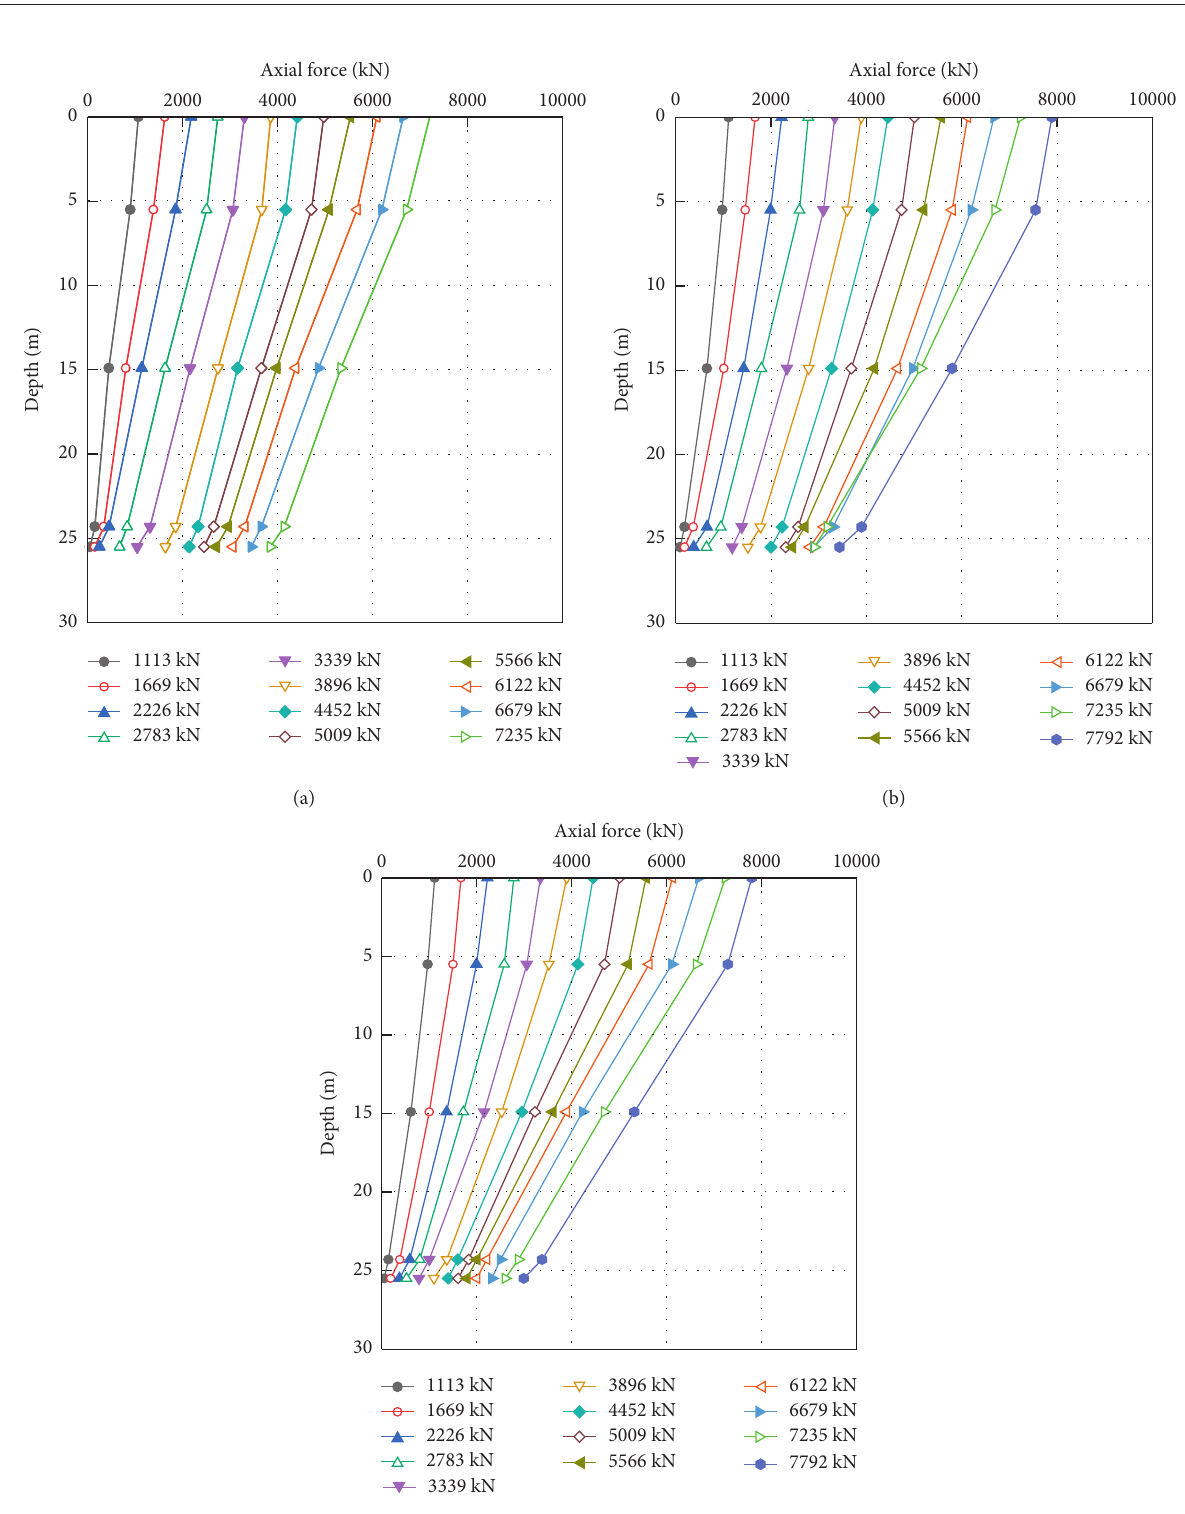
Figure 4: Axial force distribution of (a) TP1, (b) TP2, and (c) TP3.